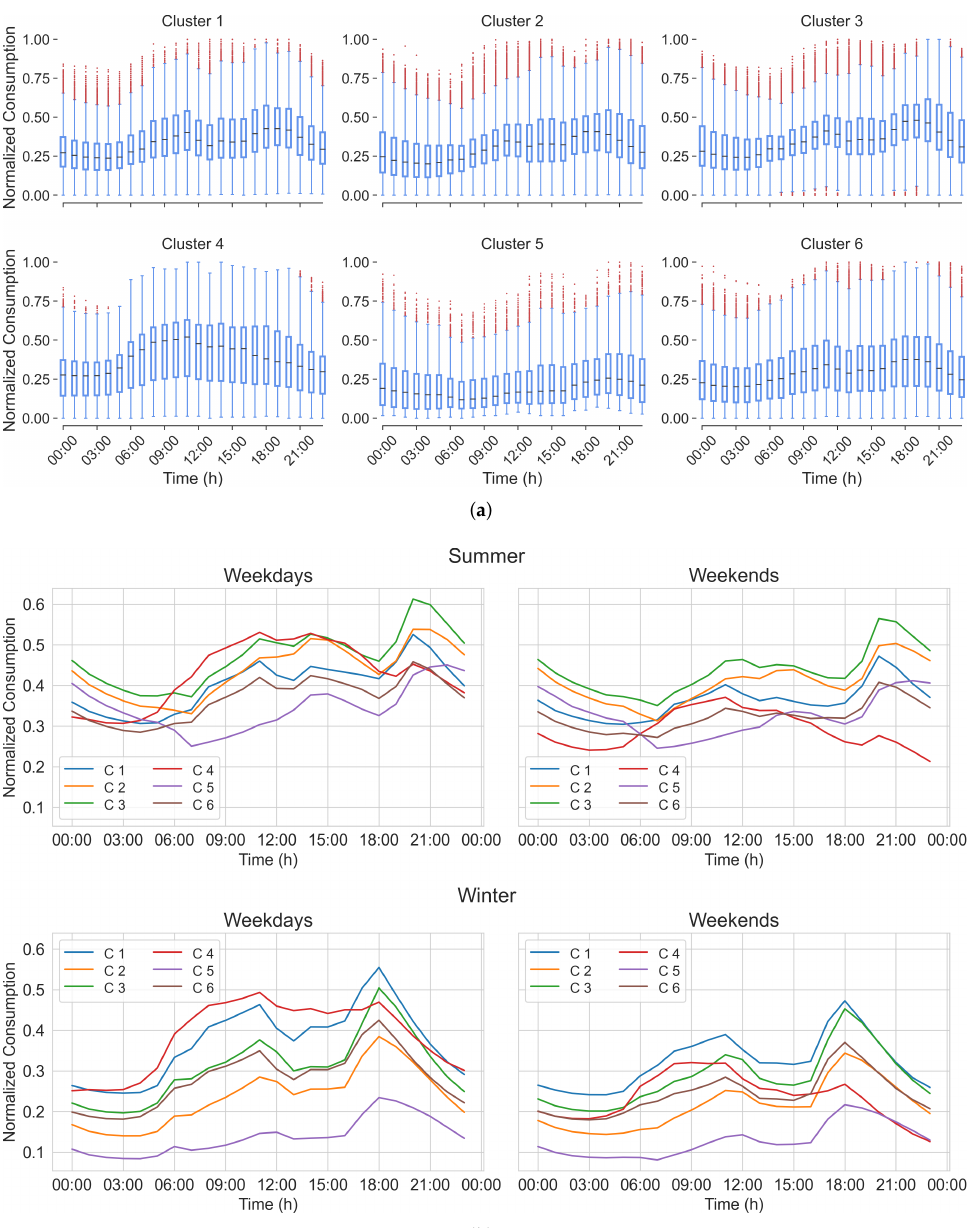
Figure 9. Consumption profiles determined in the K-means based model, where ( a ) belongs to the box plot of the mean daily consumption for each cluster and ( b ) corresponds to the mean consumption depending on the summer and winter seasons, as well as weekdays and